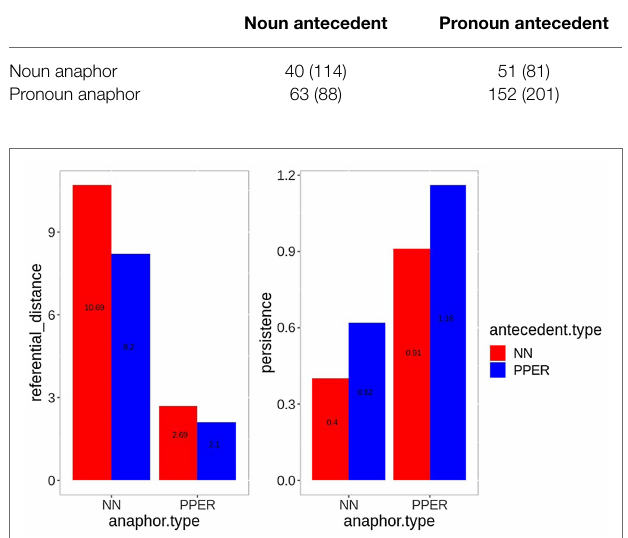
TABLE 1 | Distribution of referential types in the analyzed sample and the whole audio book recording (in parentheses).